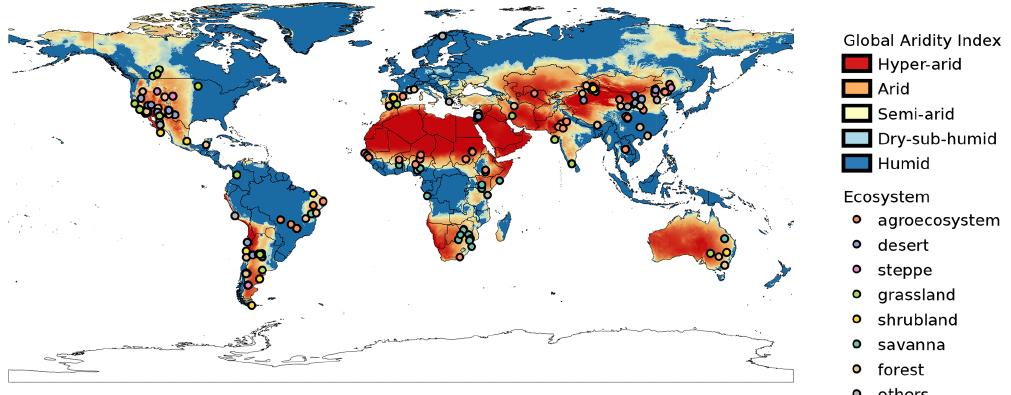
Figure 2. GAI map generated using data from the WorldClim 2 database. Hyper-arid: 0–0.03. Arid: 0.03–0.2. Semi-arid: 0.2–0.5. Dry sub- humid: 0.5–0.65. Humid: > 0 . 65. Points represent study sites in the aridec database. Colors represent different ecosystems as reported in the original publications.